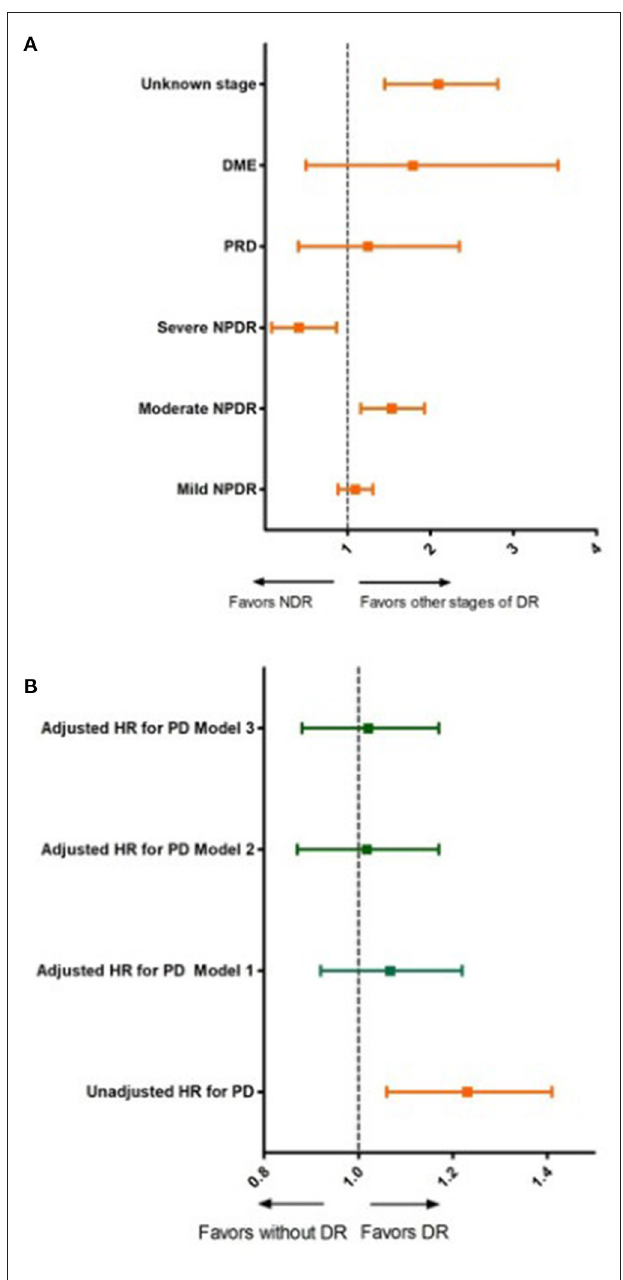
FIGURE 2 | Unadjusted and adjusted hazard ratios for Parkinson’s disease according to diabetic retinopathy status and stage of diabetic retinopathy. (A) Unadjusted hazard ratios for Parkinson’s disease for different stages of diabetic retinopathy. DR, diabetic retinopathy; NDR, no apparent diabetic retinopathy; NPDR, non-proliferative diabetic retinopathy; PRD, proliferative diabetic retinopathy; DME, diabetic macular edema. (B) Unadjusted and adjusted hazards ratios for Parkinson’s disease for subjects with and without diabetic retinopathy; Model 1: adjusted for age and sex; Model 2: adjusted for, age, sex, diabetes duration, smoking status, hypertension, dyslipidemia and body mass index; Model 3: adjusted for age, sex, diabetes duration, smoking status, hypertension, dyslipidemia, CKD, CVD and BMI and HbA1c.